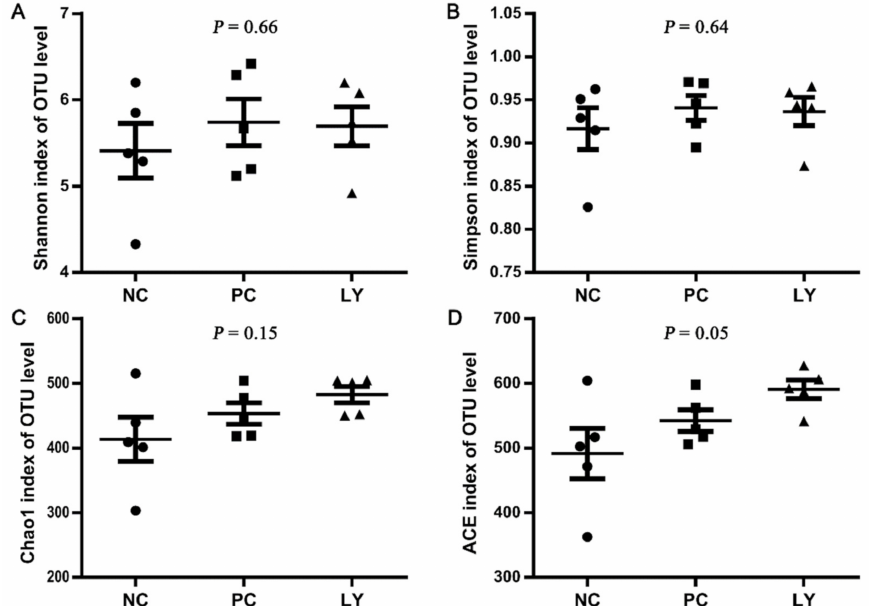
Figure 1. Cecal microbial α -diversity of broilers indicated by Shannon ( A ), Simpson ( B ), Chao1 ( C ), ACE ( D ) indexes of operational taxonomic unit (OTU) level. NC—negative control, basal diets; PC—positive control, basal diets supplemented with antimicrobials; LY—basal diets supplemented with compound probiotics. Each plot, including the dots, squares, and triangles, in the figure represents one